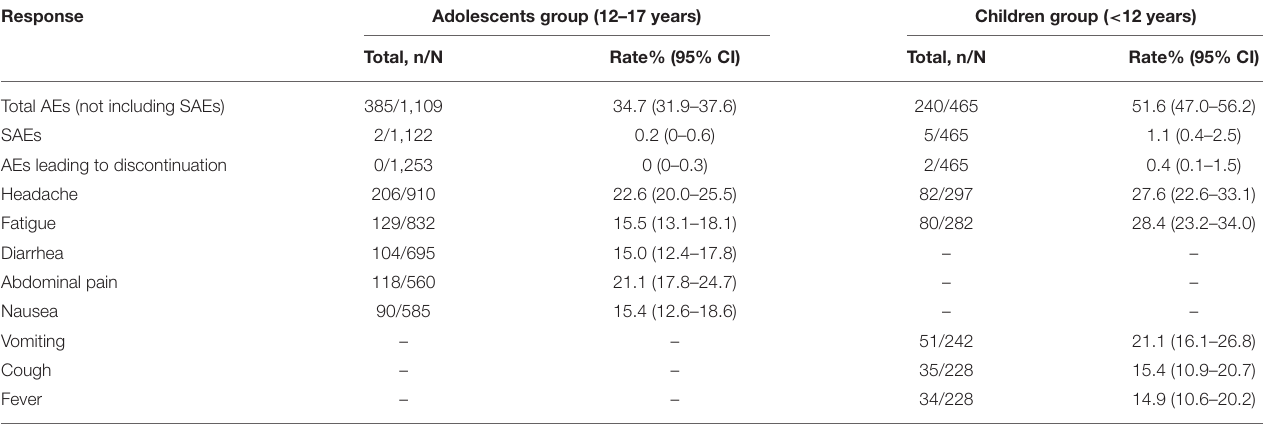
TABLE 4 | Rate of AEs, SAEs, discontinuation, and the common AEs among children and